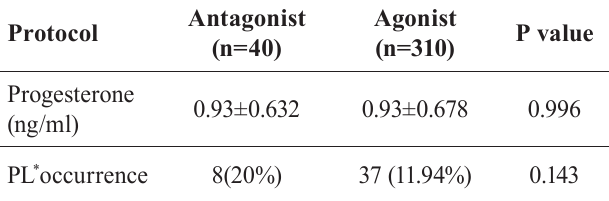
TABLE I - L evel of serum progesterone in antagonist and agonist protocols and premature luteinization occurrence